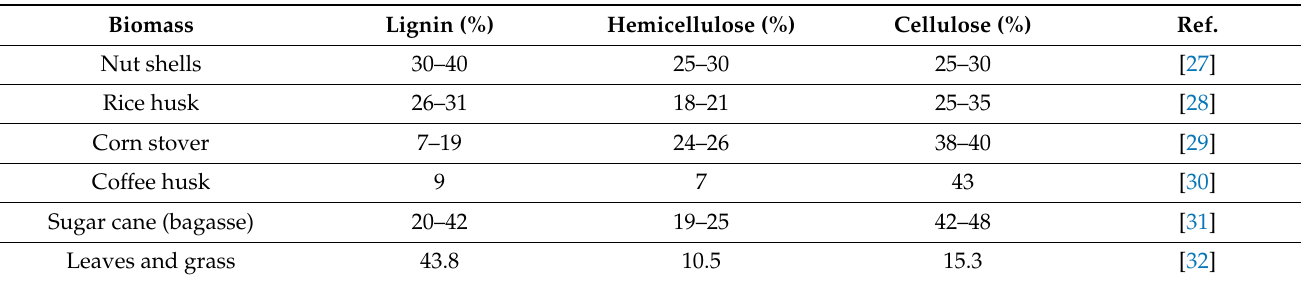
Table 1. Chemical composition of biomass for